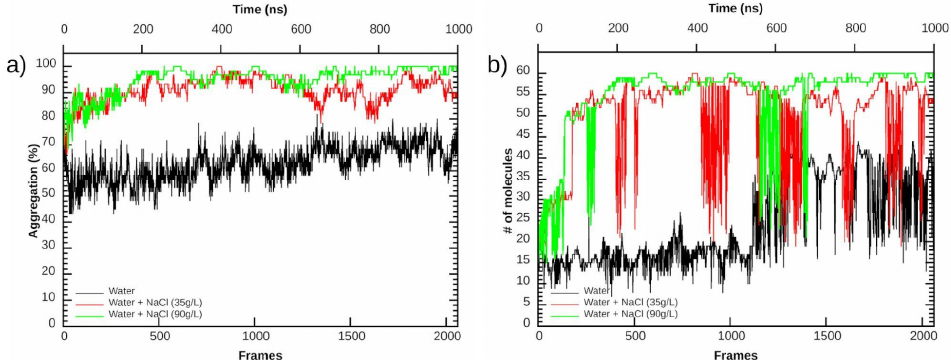
Figure 5. Percentage of aggregation ( a ) and size of largest aggregate ( b ) along the MD trajectory for the NA mixture system in pure water (black), in low salinity solution (NaCl 35 g/L—red), and in high salinity solution (NaCl 90 g/L—green).